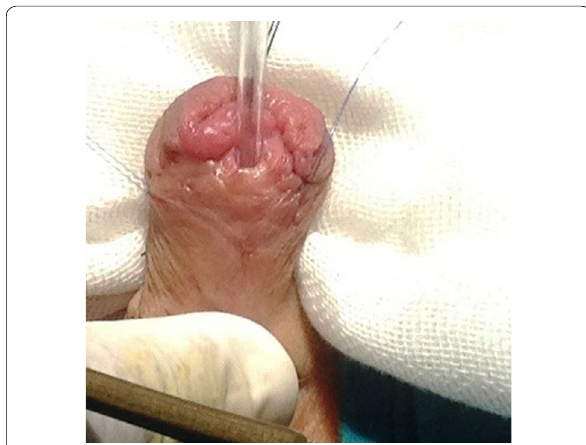
Fig. 1 Redo distal penile hypospadias with small glans penis with